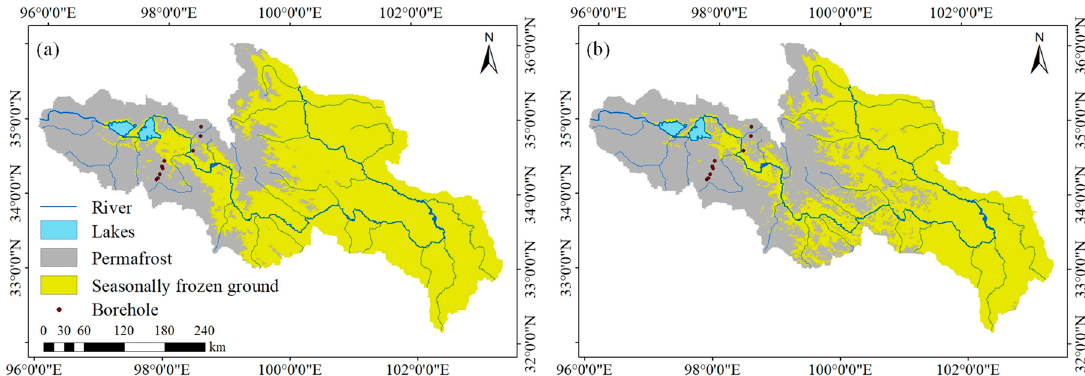
Figure 10. Map showing the distribution of the permafrost in the SRYEARS: ( a ) the results of this study, ( b ) the map from Zou et al. [39].